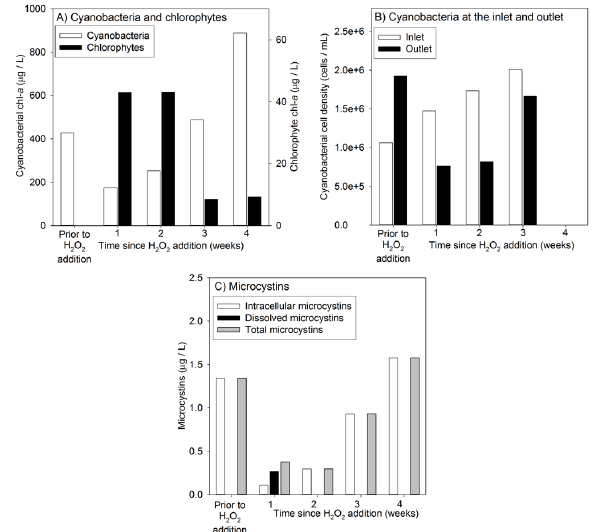
Fig. 3. Results from the Merredin waste stabilisation pond full-scale trial. Weekly averages are displayed in (A) and (C) . (A) demon- strates changes in biomass of cyanobacteria and Chlorophyta (mea- sured using spectrofluorescence) at the pond outlet, (B) the be- haviour of cyanobacteria (measured as cell density) at both the inlet and outlet and (C) the behaviour of intracellular and dissolved mi- crocystins at the pond outlet. All microcystins concentrations are expressed as microcystin-LR